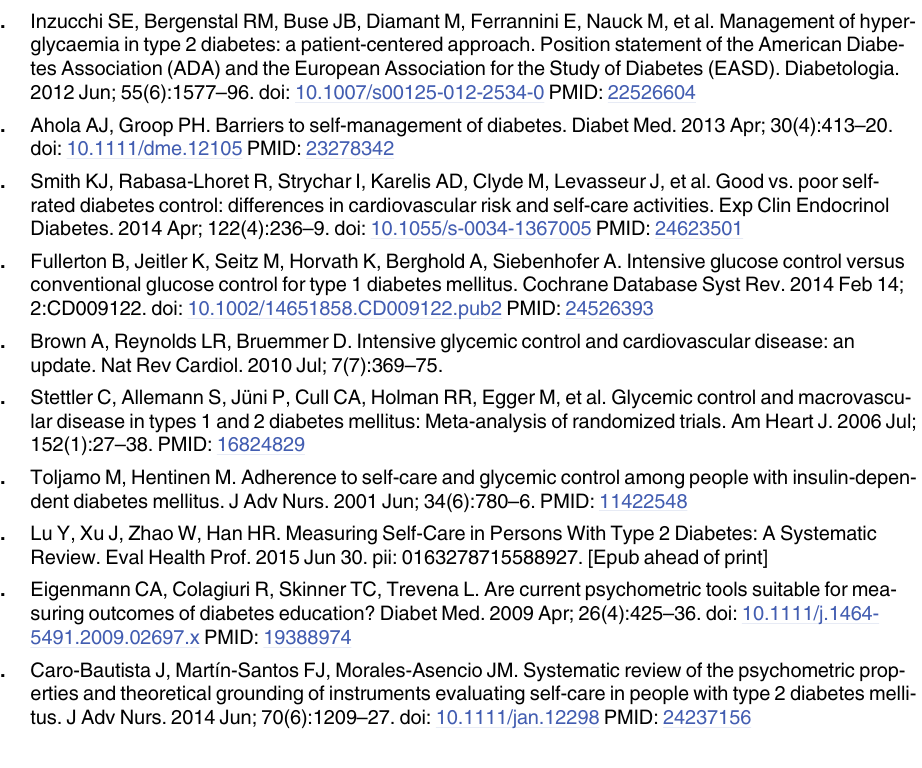
S1 Table. Diabetes Self-Management Questionnaire